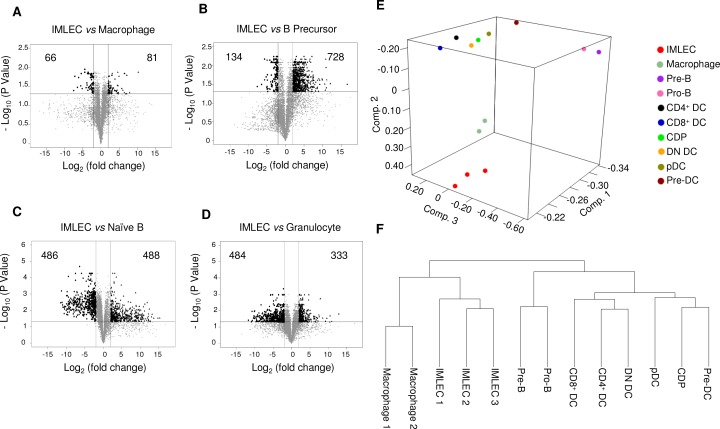
In silico pair wise comparisons between IMLECs and other closely related leukocytes based on our RNA-seq data and the publically available RNA-seq data.(A–D) Based on the space proximity in the PCA data, macrophage (A), B precursor (B), naive B (C) and granulocyte (D) were selected for one-to-one comparison. Numbers in corners indicate amounts of genes significantly (FDR-adjusted p-value<0.05) up-regulated (right) or down-regulated (left) by at least 4-fold. (E, F) IMLECs in Raptor cKO BM are distinct from all DC subsets tested. (E) Principal component analysis (PCA) of gene expression in Raptor cKO CD11b+ Gr-1- BM cell (IMLEC), macrophage, B precursors and various ex vivo DC subsets. Numbers along axes indicate relative scaling of the principal variables. (F) Clustering of IMLEC, macrophage, B precursors with other DC subsets based on their gene expression profiles. Hierarchical clustering with complete linkage was carried out using the R software. The public RNA-seq datasets for DC subsets used are as followings: CDP (common DC precursor, GSM1531794); pDC (GSM1531795); preDC (GSM1531796); DN DC (CD4 and CD8 double negative DC, GSM1531797); CD4+ DC (GSM1531798) and CD8+ DC (GSM1531799).